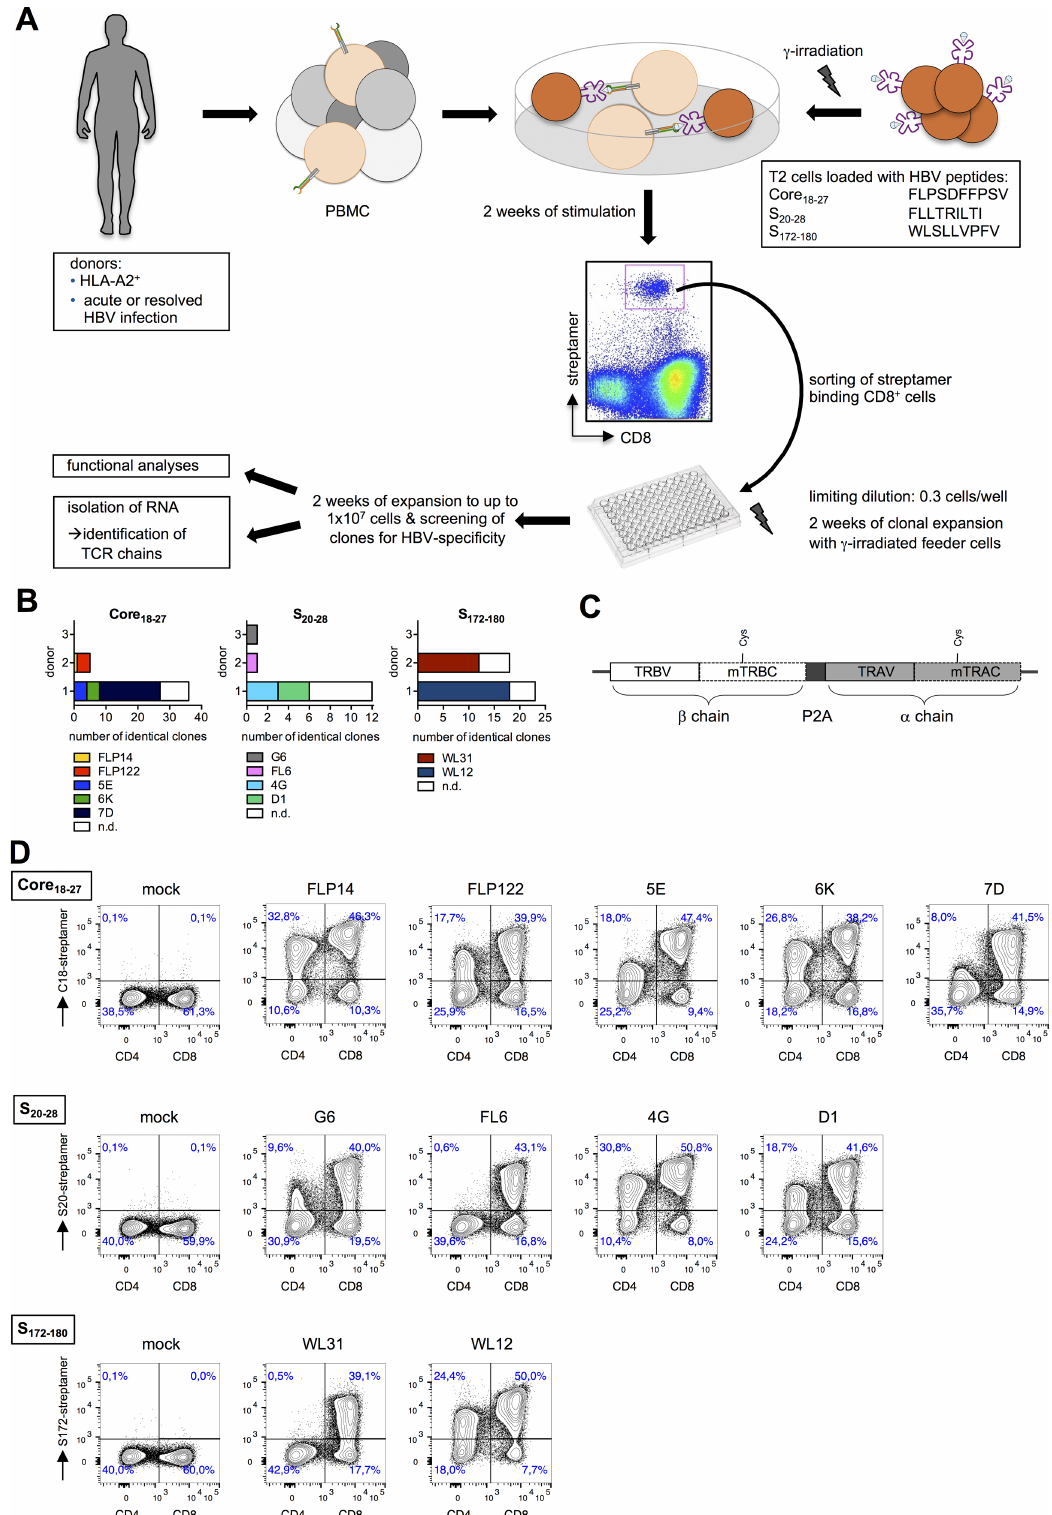
Fig 1. Isolation of HBV-specific T cells. (A) Experimental procedureto isolate HBV-specific T cells. T cells from donor1 with acute, donor2 with protractedanddonor 3 with resolvingHBV infectionwere stimulated for two weeks with peptide-